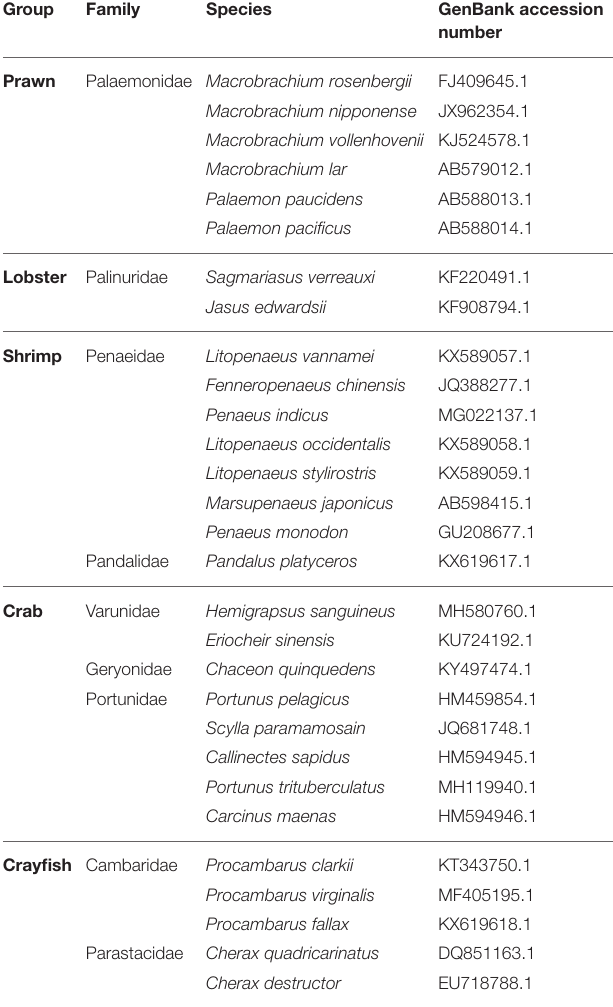
TABLE 1 | IAG in decapod crustacean